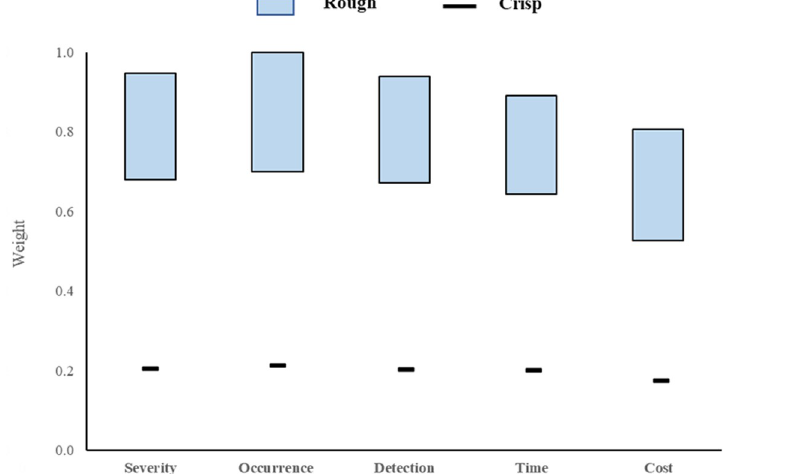
Fig 2. Comparison of weights using the rough and crisp value.